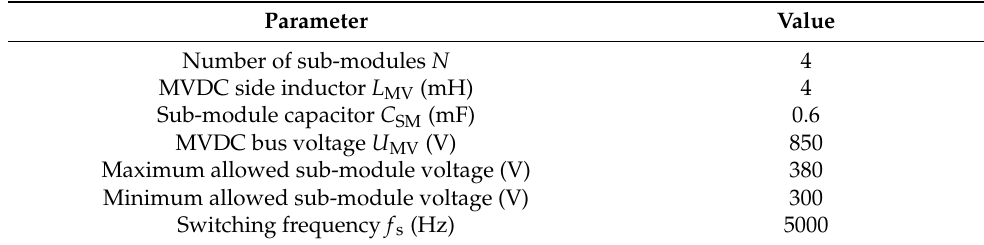
Table 2. Parameters of the MMC–BDC prototype.